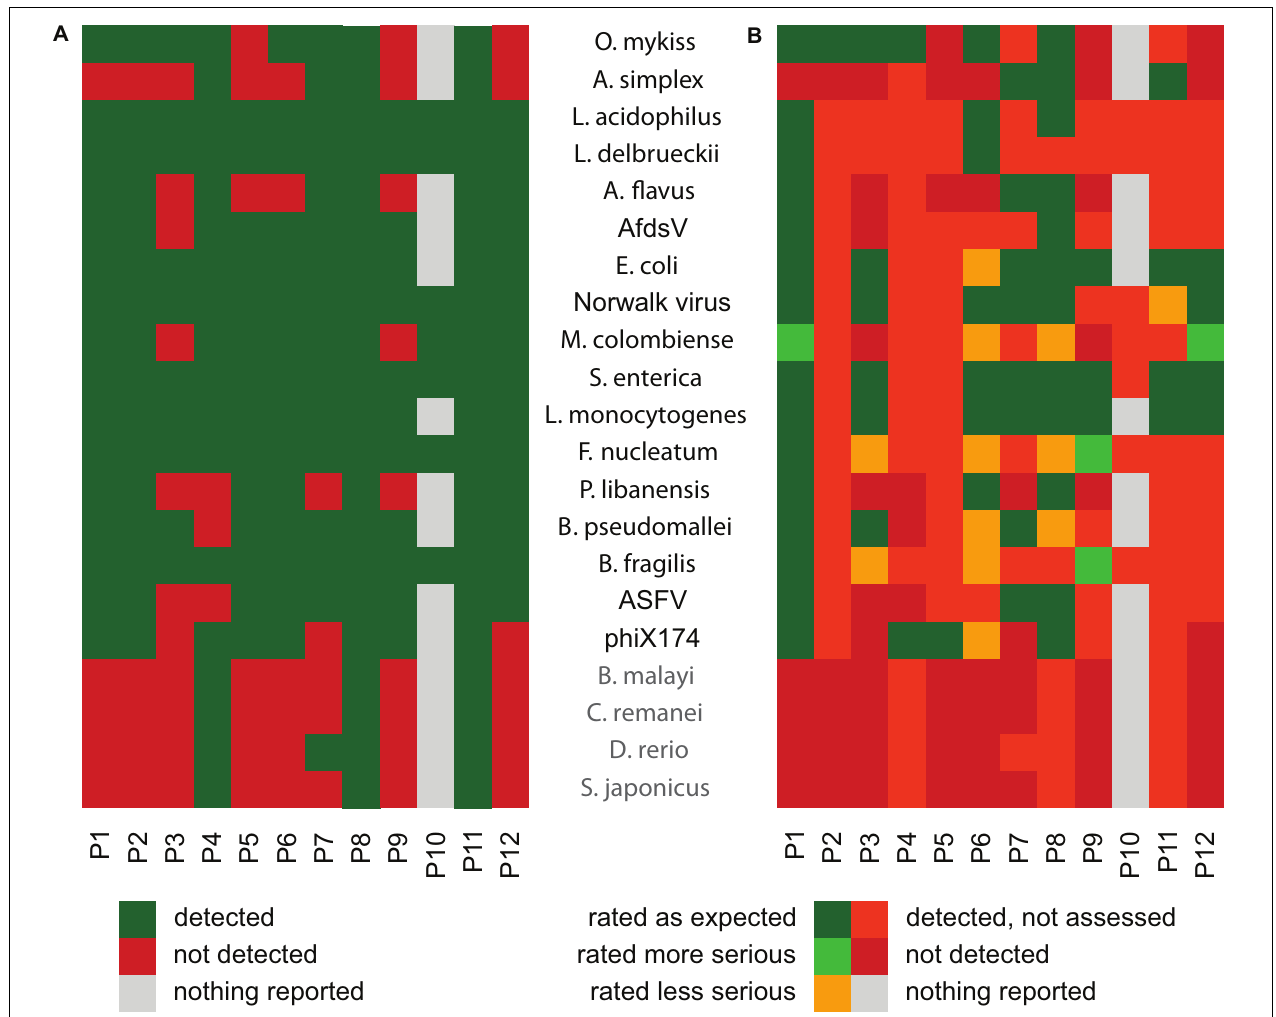
FIGURE 4 | Summary of the read-assignment tables (A) , and assessment and interpretation of the assignments (B) . Heatmap showing the positive (comprised species detected; green) and negative (comprised species NOT detected; red) results of the software analyses. The results shown for participants are based on their uploaded read assignment tables, except for P10, for which the results are derived from their summary table and assessment (A) . Heatmap summarizing assessments of the detected species by the participants (B) . Sequences of the taxa labeled gray ( Brugia malayi , Caenorhabditis remanei , Danio rerio , and Scomber japonicus ) were downloaded unintentionally as part of the Anisakis sequence